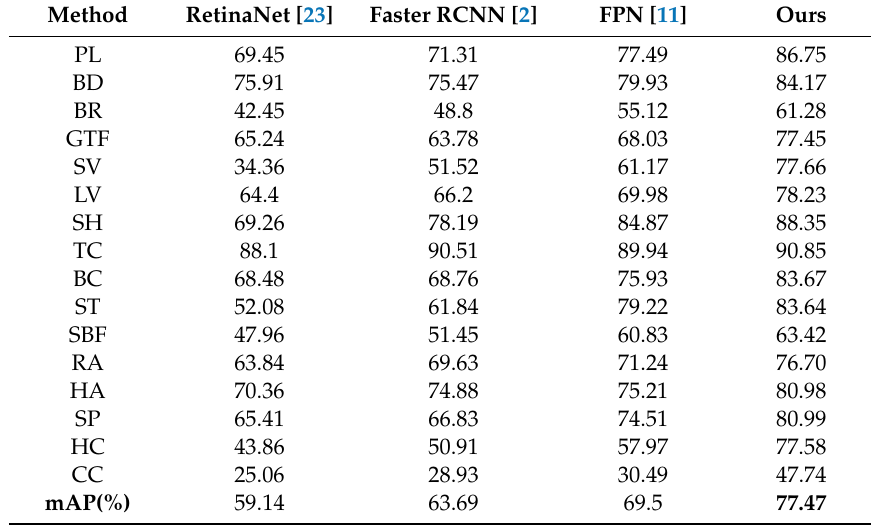
Table 5. Comparison results on the DOTA-v1.5 test set. The abbreviation names of categories follow [19] and are described in detail in Section 4.1.1. The bold numbers represent the best detection